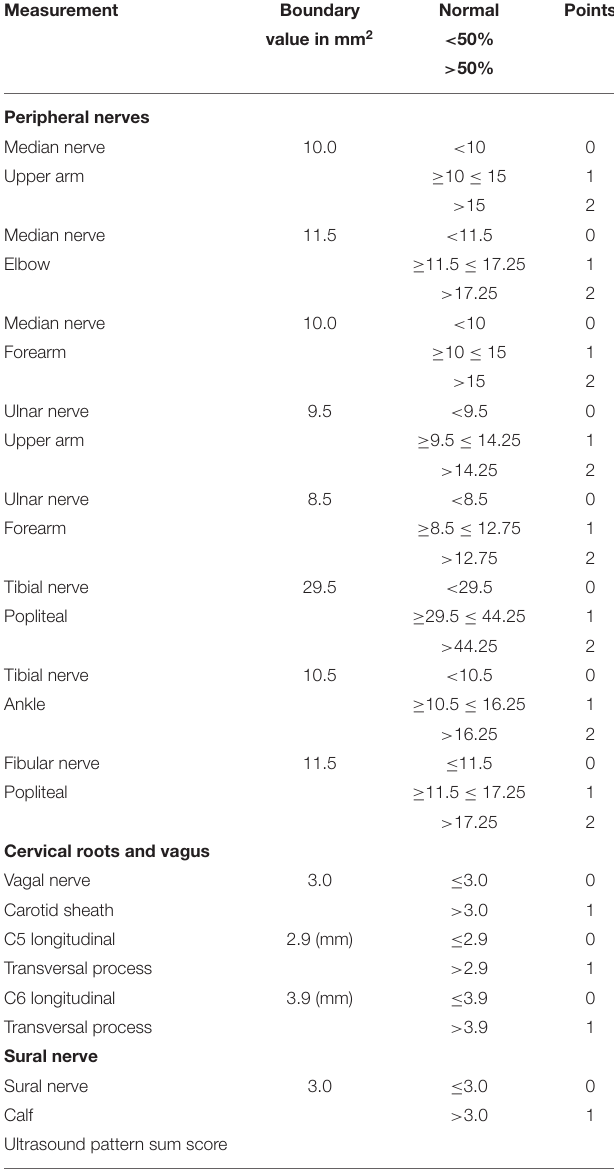
TABLE 1 | The ultrasonic pattern sum score